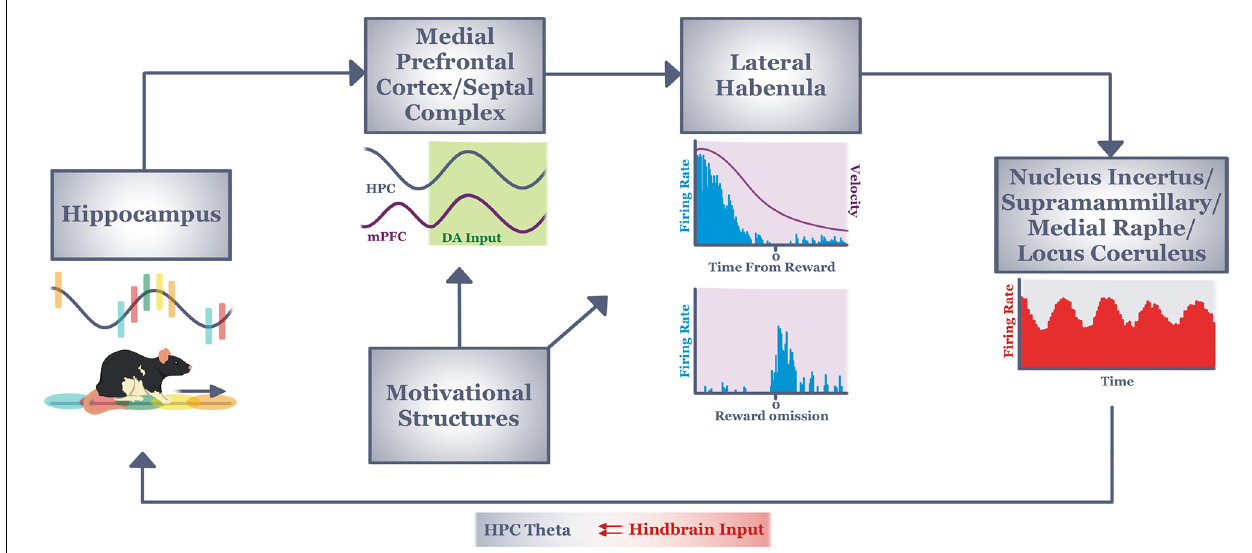
FIGURE 2 | Information flow through our hypothesized circuit (see text) that mediates context-dependent response flexibility during active navigation. Context information from the hippocampus (in the form of place field sequences) informs decision processes of the medial prefrontal cortex and septal complex via reward-modulated theta coherence. The output of this memory/decision system integrates with motivational information in the lateral habenula. Lateral habenula neurons integrate this information over many seconds to discharge tonically (to encode current behavioral state, or velocity) or phasically (to encode short duration stimuli/events such as reward outcome). Both types of signals are driven by motivational, memory and decision processing (see text). The output of lateral habenula is hypothesized to provide a signal to hindbrain regions known to regulate hippocampal theta. In this way, the lateral habenula may establish/maintain a neural state in hippocampus that encourages the increased attention and exploratory tendencies needed for animals to respond flexibly to changing task conditions. DA, dopamine; HPC, hippocampus; mPFC, medial prefrontal